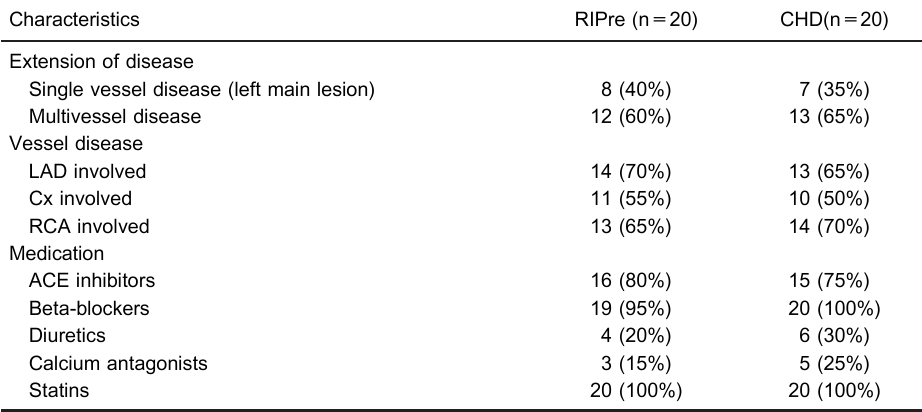
Table 2. Quantitative coronary angiographic data and medical treatment of remote ischemic preconditioning (RIPre) and coronary heart disease (CHD) patients.